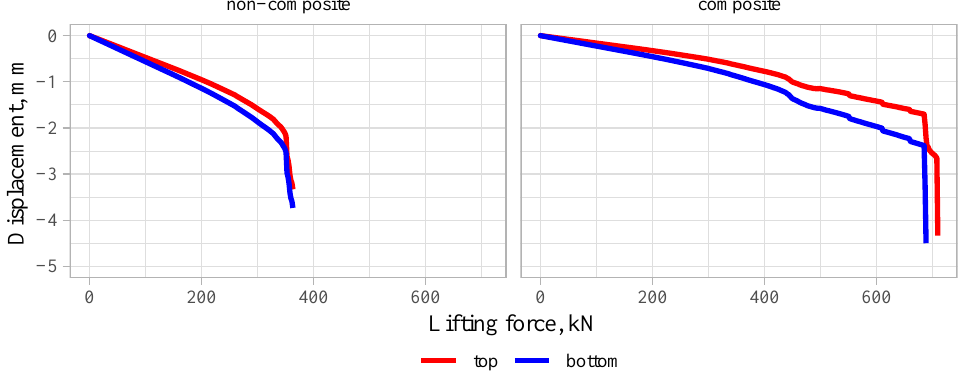
Figure 14. Theoretical deflection of the wall during demoulding related to the pseudo lifting